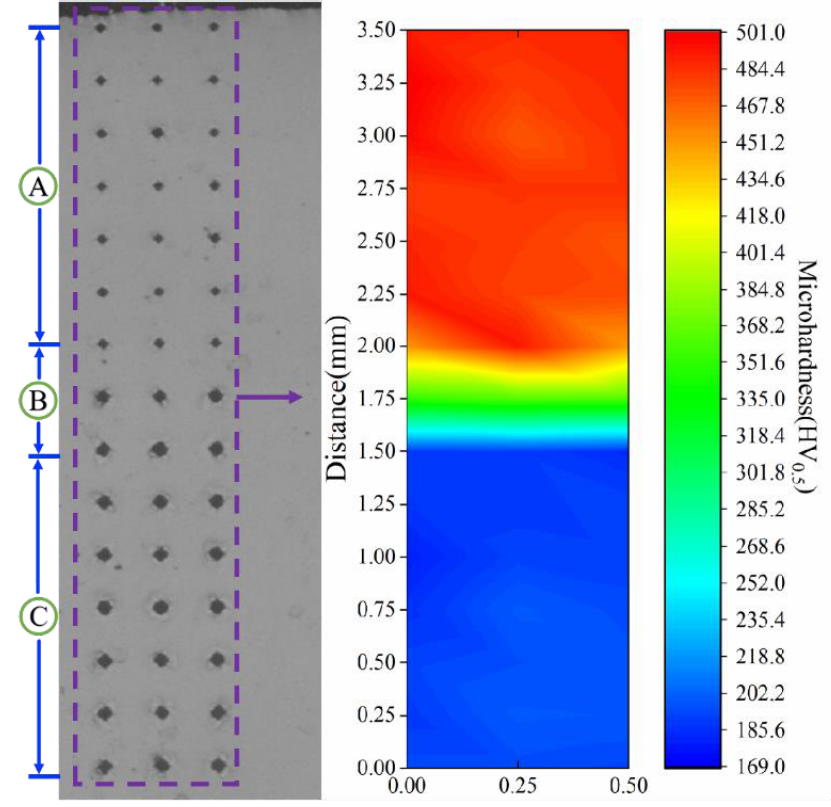
Figure 5. Microhardness distribution diagram from the top of the FeCrSiNiCoC coatings to the 1Cr11Ni heat resistant steel substrate.